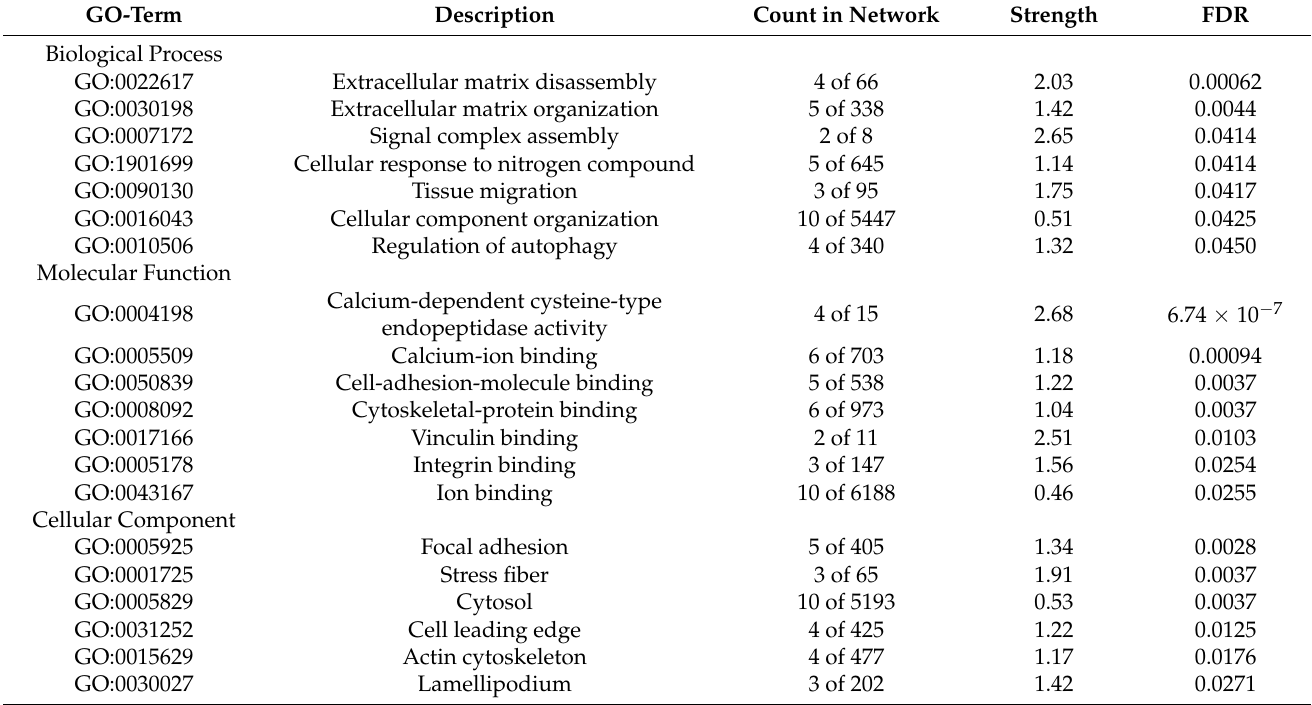
Table 1. Gene ontology characteristics related to CAST.